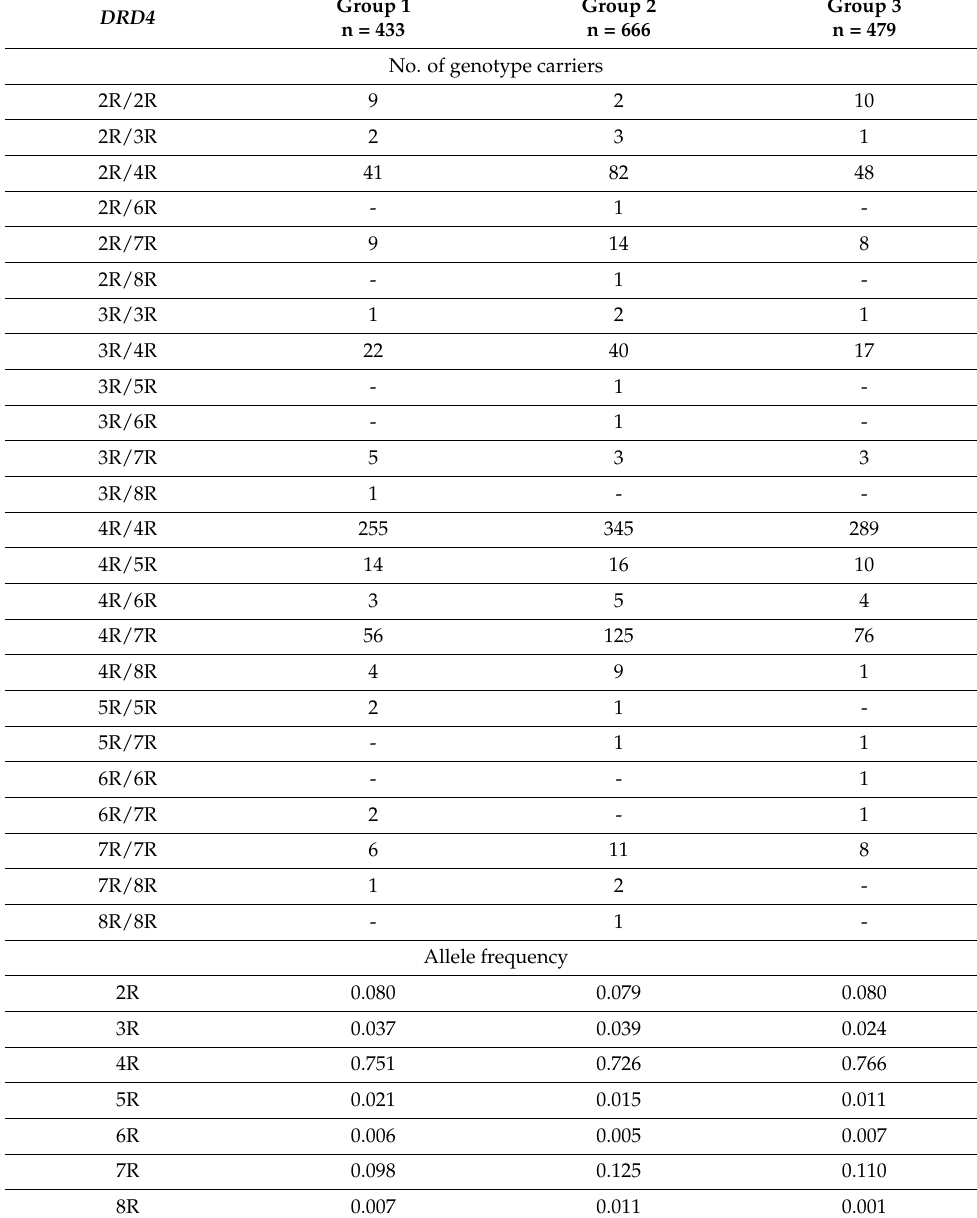
Table 5. Numbers of genotype carriers and allele frequencies for the exon 3 VNTR in the DRD4 gene in the three groups of adolescents (1: born in 1982–1985, 2: in 1992–1995, and 3: 2002–2005); n: the number of all such carriers in a group, R: the number of